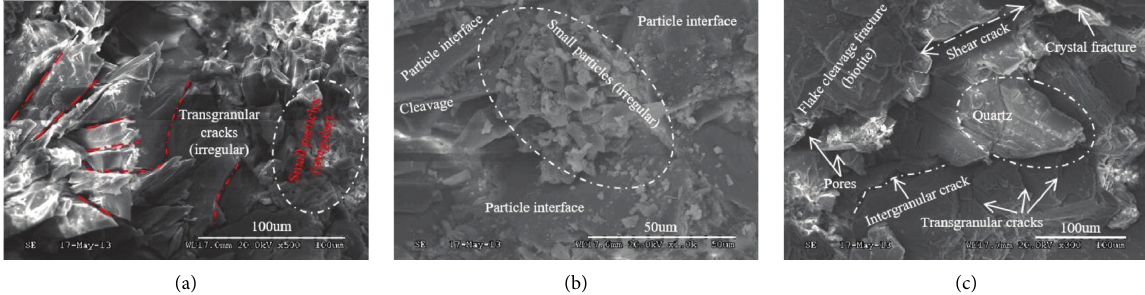
Figure 5: Main microfeatures of quartz. (a) Irregular, with many randomly distributed intergranular and transgranular cracks in granite samples. (b) Irregularly distributed particles in granite samples. (c) Granule bulges rupture fractures in granite